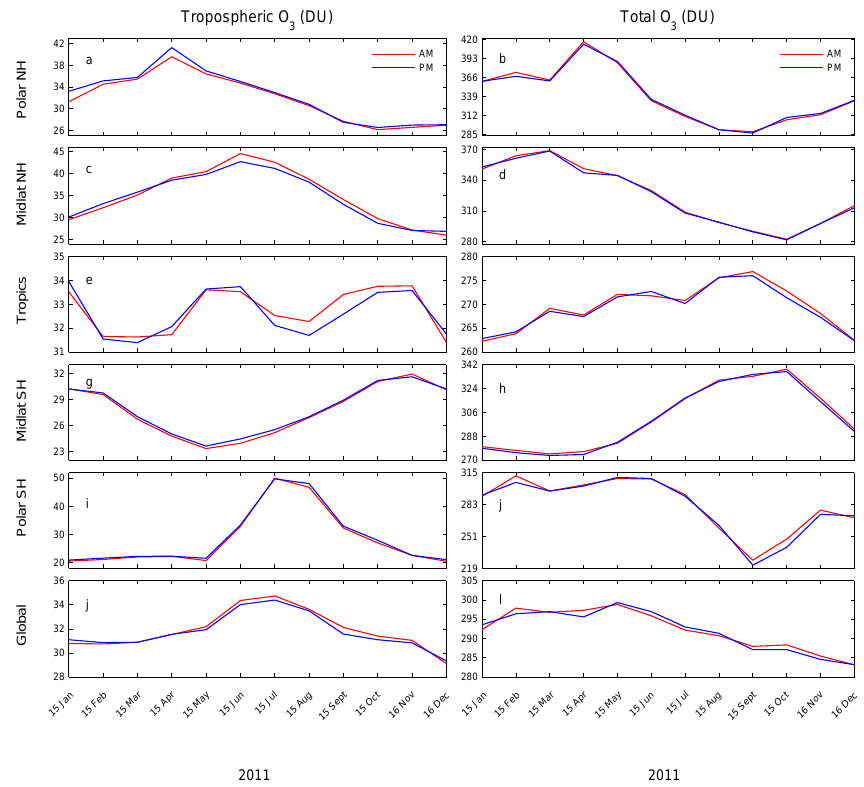
Figure 8. Same as Fig. 6 but for tropospheric and total columns of O 3 in